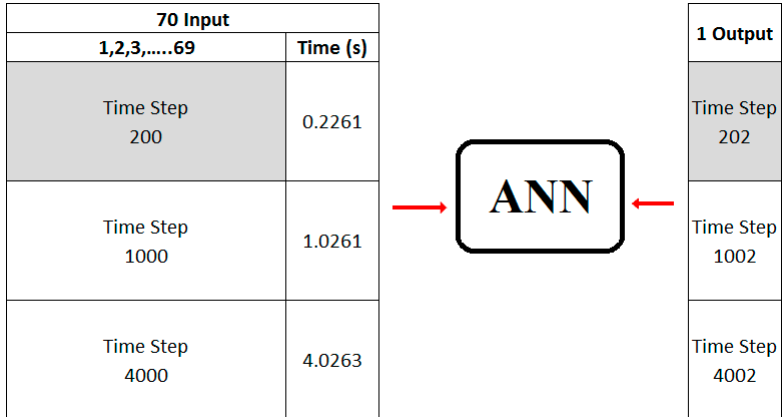
Figure 21. Input and output pair for the training. Fluids 2019 , 4 , x